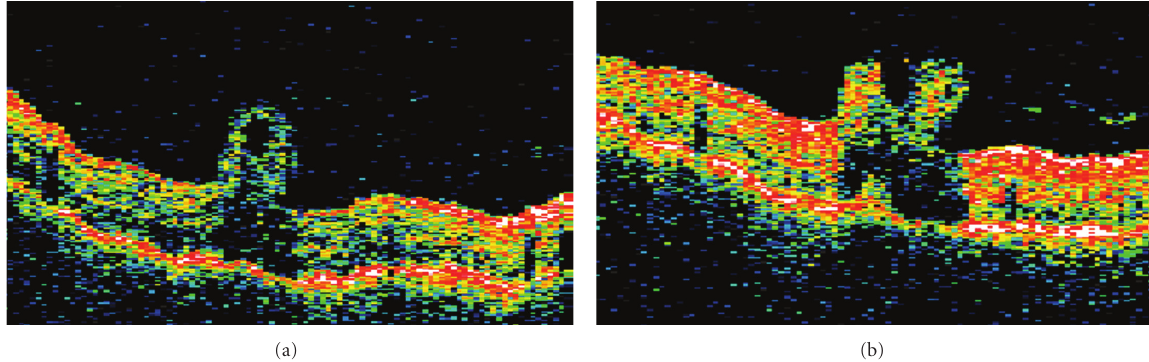
Figure 2: Vertical macular OCT scans of case 2 show neurosensory folding with subjacent optical shadowing. Note the uninvolvement of the retinal pigment epithelium in the fold area ((a): right, (b): left).